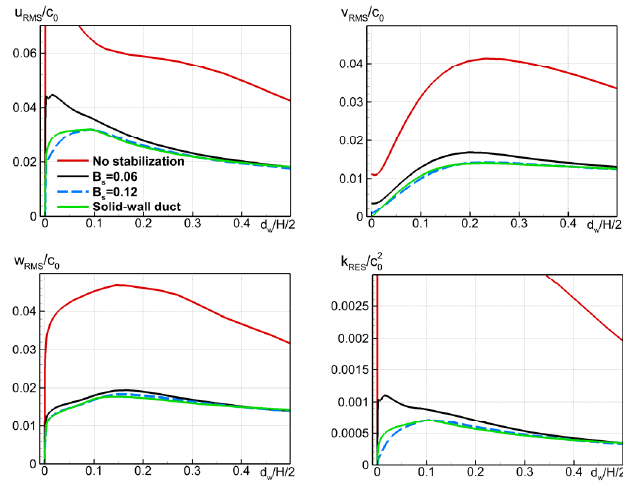
Figure 27. Effect of stabilization (10) and its amplitude parameter B s on wall-normal profiles of root-mean-square pulsations of velocity and resolved TKE at section x = 0.6 m of NASA GFIT flow.